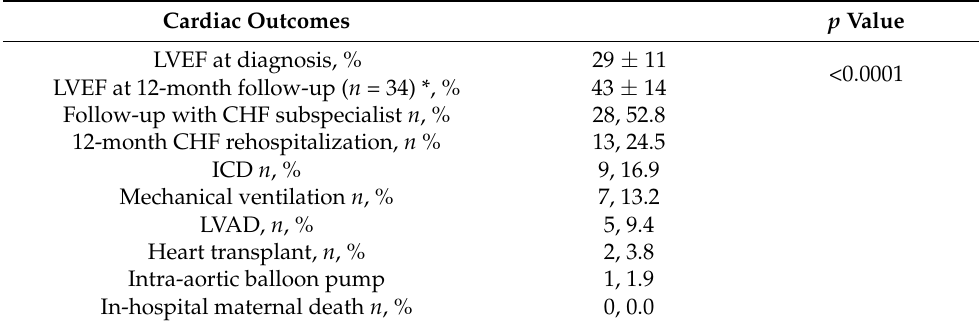
Table 4. Cardiac outcomes in women with PPCM ( n = 53). Cardiac Outcomes p Value LVEF at diagnosis, % LVEF at 12-month follow-up ( n = 34) *, %